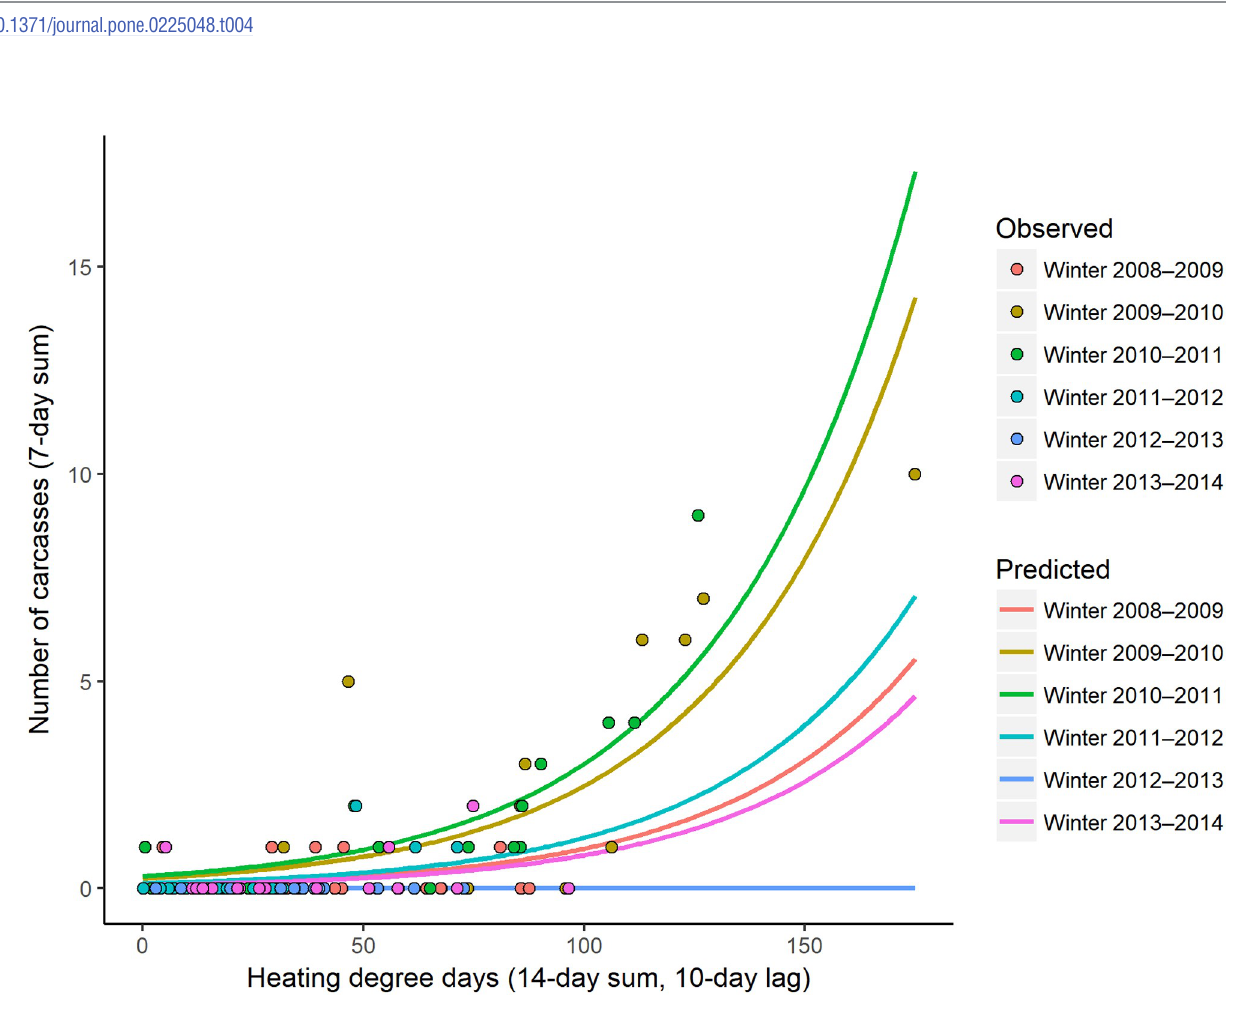
Fig 6. The predicted 7-day counts of cold-related manatee carcasses reported in the central-west region using air temperature based on the short- term temperature effect (14-day sum, lagged by 10 days; x-axis) by winter from the top-ranked model. Each line represents a different winter, and the circles represent the observed numbers of cold-related carcasses reported over 7 days, color-coded by winter.